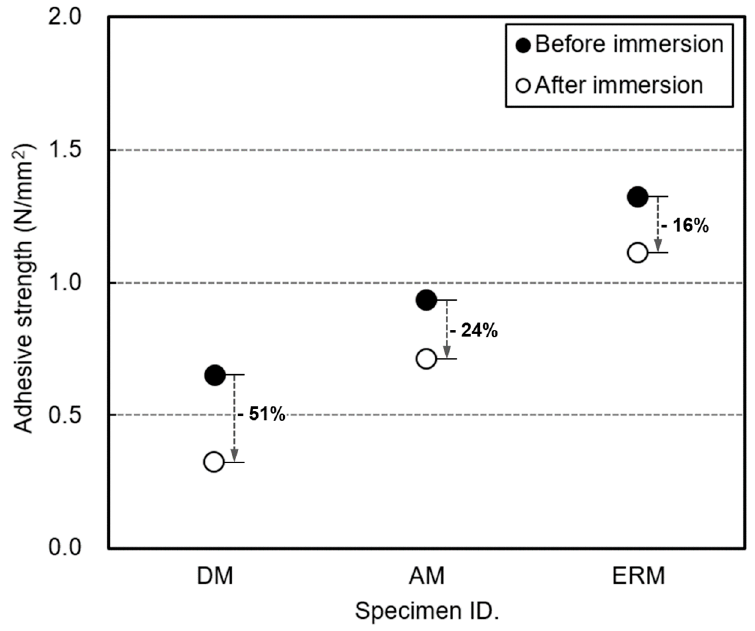
Figure 14. Adhesive strength of porcelain tile by salt immersion.